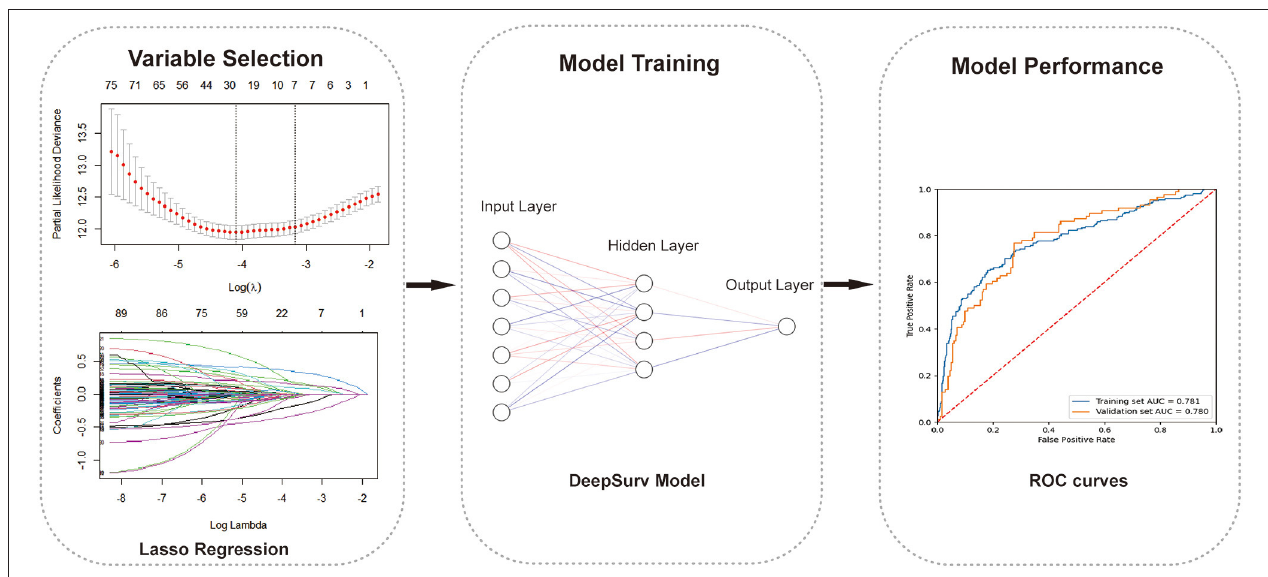
FIGURE 1 | The working process of this study. The study procedure consisted of variables selection, model building, and model evaluation.